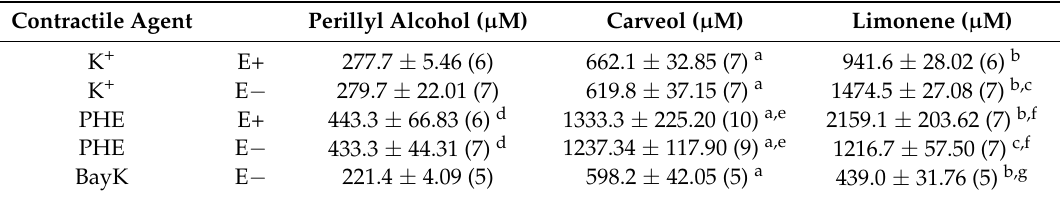
Table 1. EC 50 values summarizing the relaxant effects of perillyl alcohol, carveol, and limonene on rat aortic rings. Values are expressed as means ± SEM.